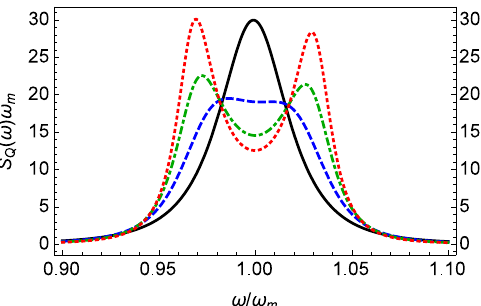
Figure 5. The position spectrum S Q ( ω ) × ω m of the movable mirror versus the normalized frequency ω / ω m for different reflection coefficients r = 0 (black solid), 0.2 (blue dashed), 0.3 (green dot-dashed), 0.35 (red dotted).